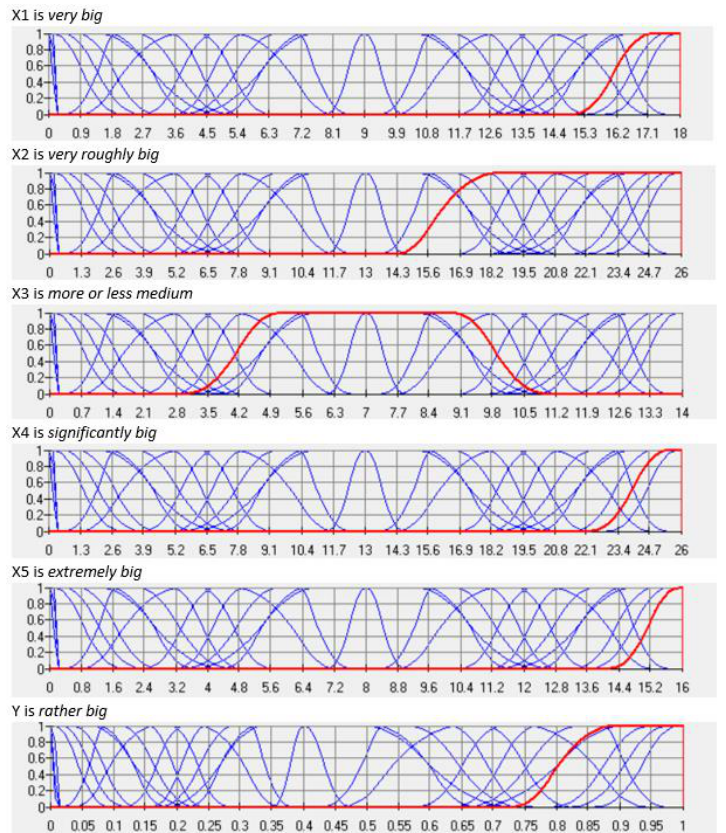
Figure 7. Fuzzy sets, for example, rule X1, …, X5, Y (ve bi, vr bi, ml me, si bi, ex bi, ra bi; the red color means active fuzzy set).